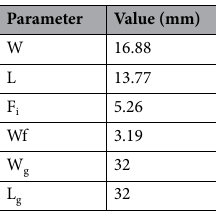
Table 1. Geometrical parameter of the considered patch